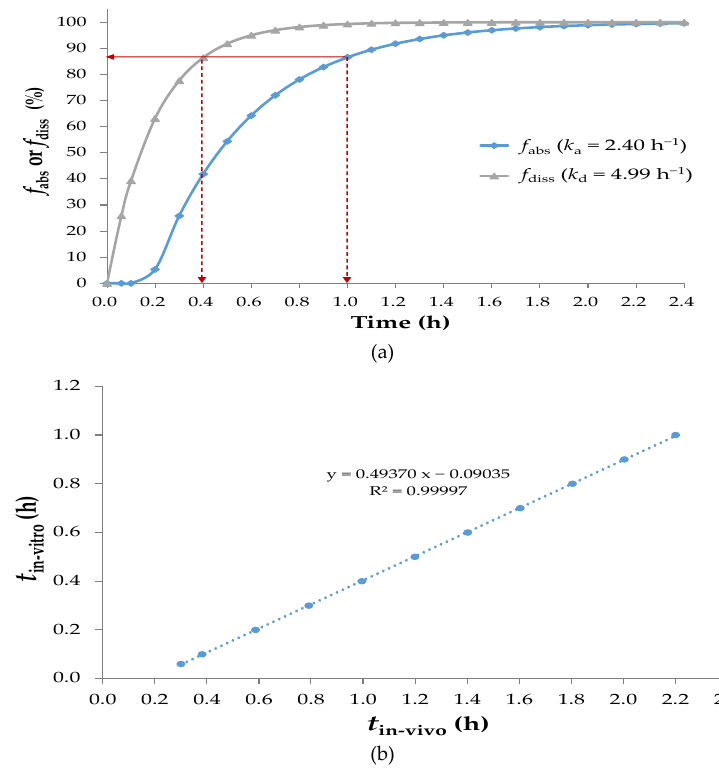
Figure 3. ( a ) The in vivo f abs and in vitro f diss versus time; ( b ) A linear regression of t in-vitro for dissolu- tion versus t in-vivo for absorption. Indicating that sobrerol had a favorable time-scaling IVIVC.